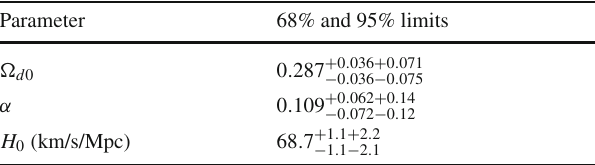
Fig. 4 Combined constraints (SNe Ia and H ( z ) ) on (cid:4)( t ) CDM model Table 2 Combined constraints on the free parameters of (cid:4)( t ) CDM model from Pantheon+ H ( z ) data for 68% and 95%